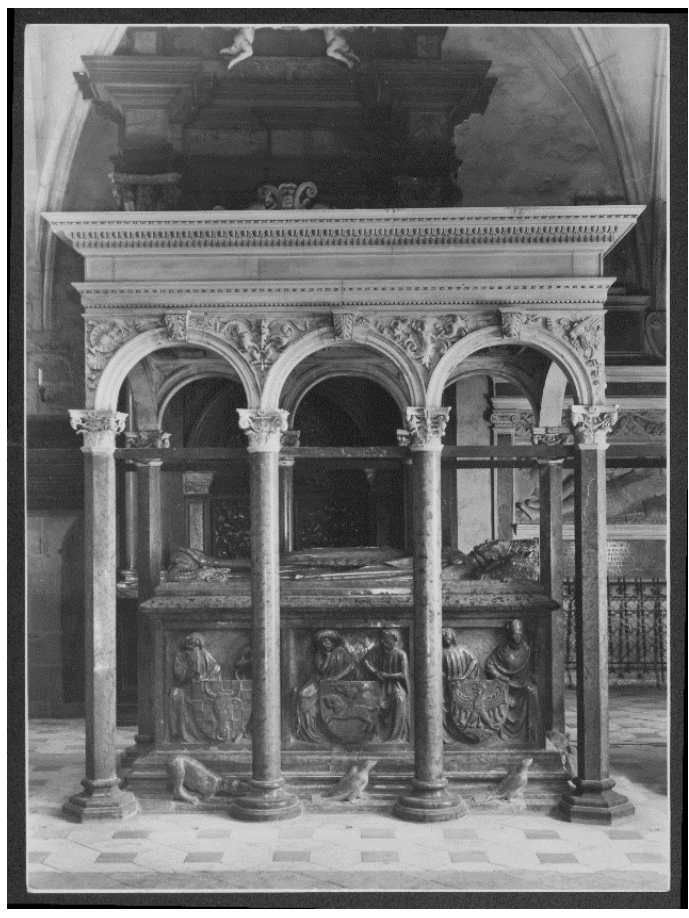
Figure 5. Tomb Ladislaus Jagiełło, before 1430, Cracow, cathedral, the easternmost arcade between the nave and the south aisle, photo published in [37].